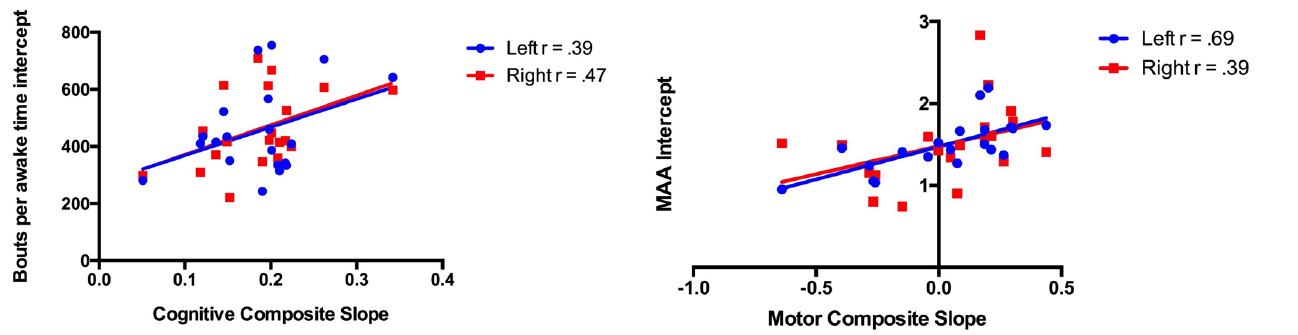
Figure 6. Scatter plot of bouts per awake time intercepts (for right and left arms) and Bayley composite cognitive slopes of each infant.